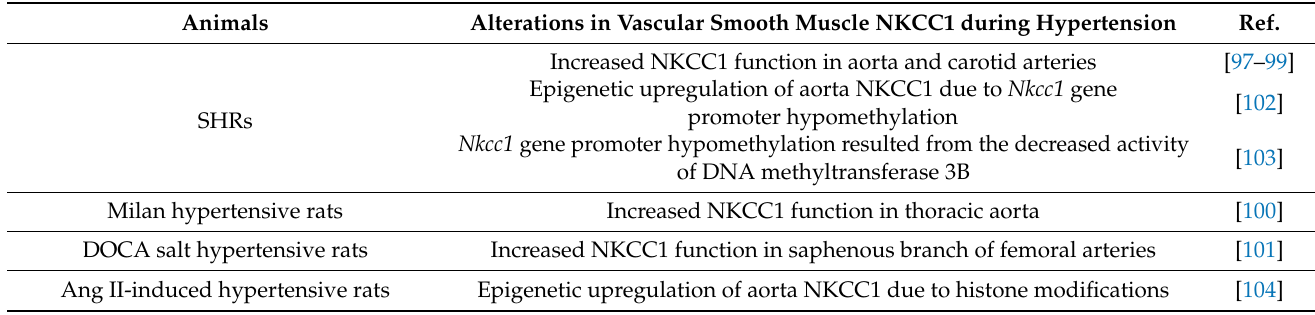
Figure 3. Upregulation of endothelial TMEM16A impairs endothelial function in hypertension. In hypertension, the expression and function of vascular endothelial Ca 2+ -activated Cl − channel TMEM16A are increased. Endothelial stimulation with agonists and shear stress increases the intracellular Ca 2+ concentration, which subsequently activates endothelial small-conductance Ca 2+ -activated K + channels (SK Ca s), intermediate-conductance K Ca (IK Ca ) and TMEM16A simultaneously. The endothelium-dependent hyperpolarization (EDH) through the activation of both SK Ca and IK Ca is reduced by the opposing membrane depolarization evoked by the activation of TMEM16A. In addition, activation of TMEM16A may facilitate the generation of reactive oxygen species (ROS) through Nox2-containing NADPH oxidase, leading to reduced bioavailability of nitic oxide (NO). Impaired EDH and/or NO could be at least partly responsible for the blood pressure rise in hypertension. Table 3. Alterations in vascular smooth muscle NKCC1 during